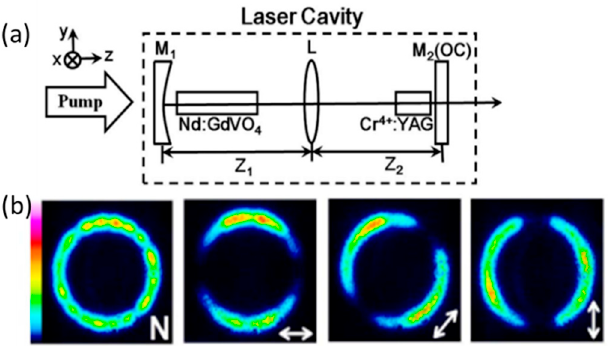
Figure 4. Nd:GdVO 4 /Cr 4+ :YAG passively Q-switched vortex laser. ( a ) Experimental setup. ( b ) An- gular polarization output.